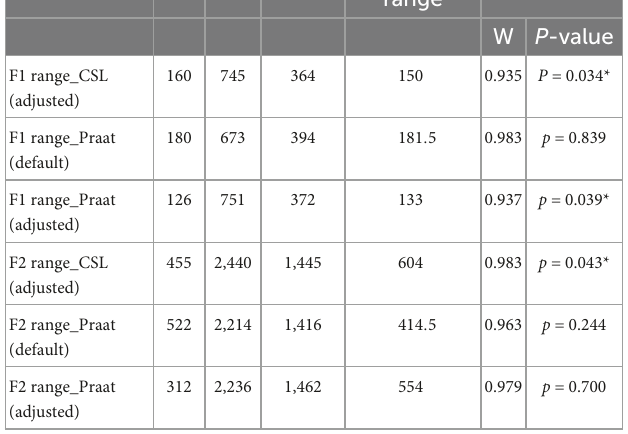
TABLE 3 Summary statistics and normality test results for F1 and F2 ranges obtained using Computerized Speech Lab (CSL) and Praat for all settings. Variable